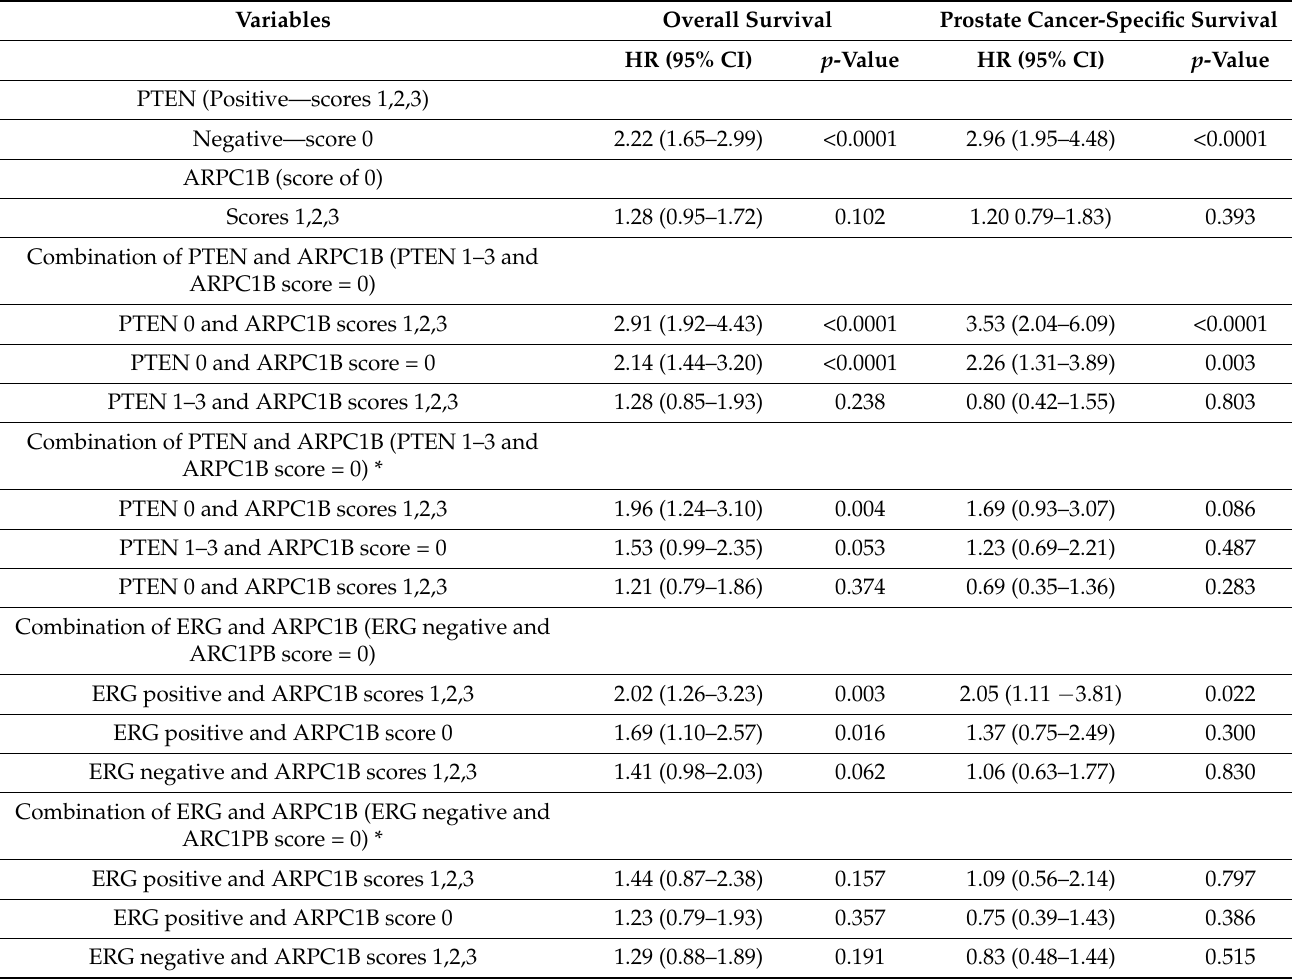
Table 1. Univariate and multivariate analysis and HR of the different biomarker combinations to overall survival and cancer-specific mortality in the TURP